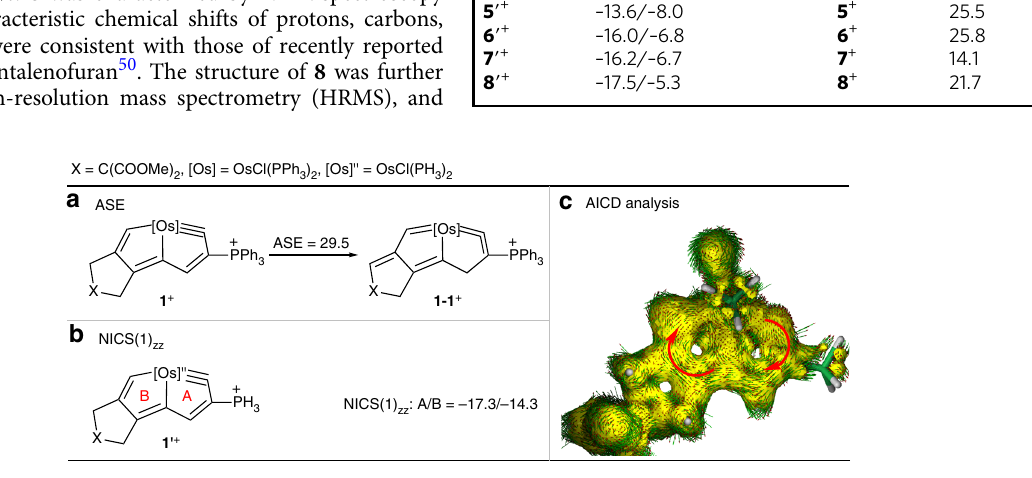
Fig. 6 Aromaticity of the cation moiety of complex 1 . a Aromatic stabilization energy (ASE, kcal/mol) evaluations of the aromaticity of the cation moiety of complex 1 . b NICS(1) zz (nucleus-independent chemical shift along the z -axis at 1 Å above the ring critical point, ppm) evaluations of the aromaticity of the cation moiety of model complex 1 ′ . c Anisotropy of the induced current density (AICD) plot of the cation moiety of model complex 1 ′ with an isosurface value of 0.025. The magnetic fi eld vector is orthogonal to the ring plane and points upward (aromatic species exhibit clockwise diatropic